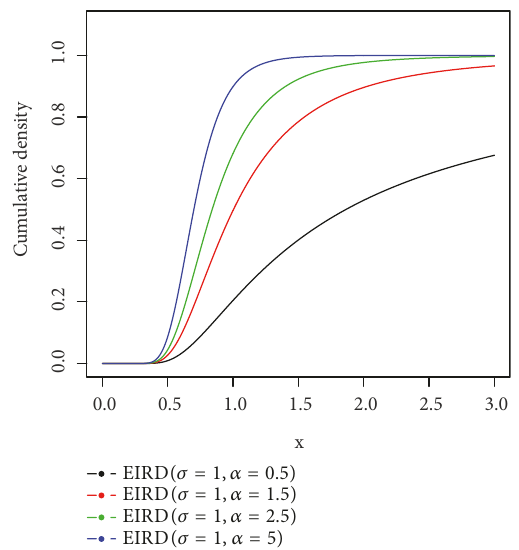
Figure 1: Probability density function of EIRD with different shape parameters.